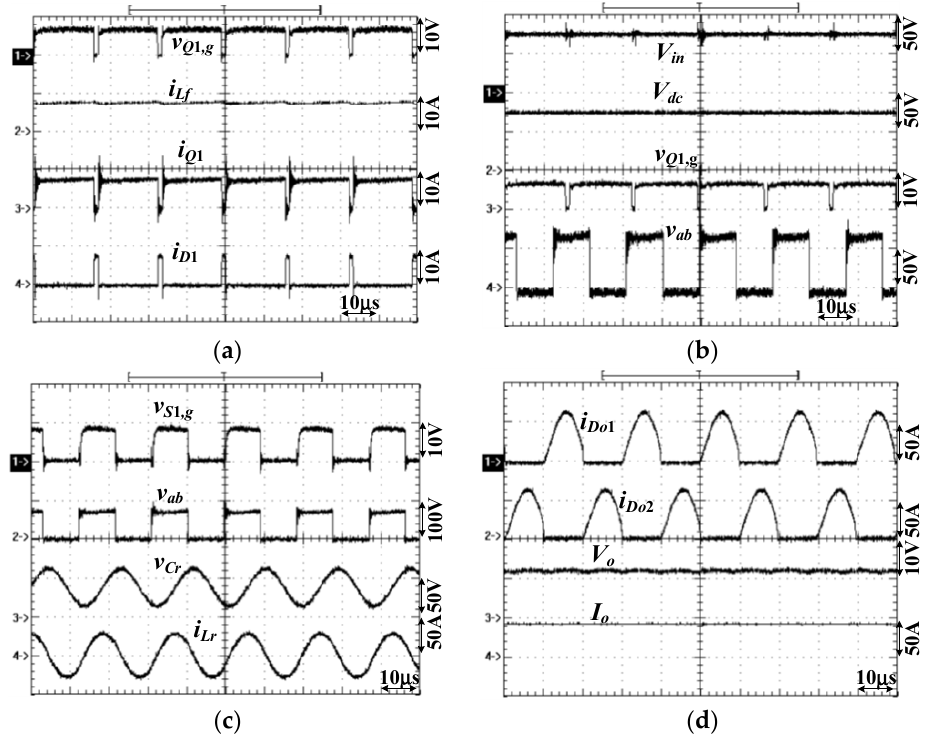
Figure 8. Measured results at V in = 76 V and P o = 500 W ( a ) v Q 1, g , i Lf , i Q 1 and i D 1 ( b ) V in , V dc , v Q 1,g and v ab ( c ) v S 1, g , v ab , v Cr and i Lr ( d ) i Do 1 , i Do 2 , V o and I o